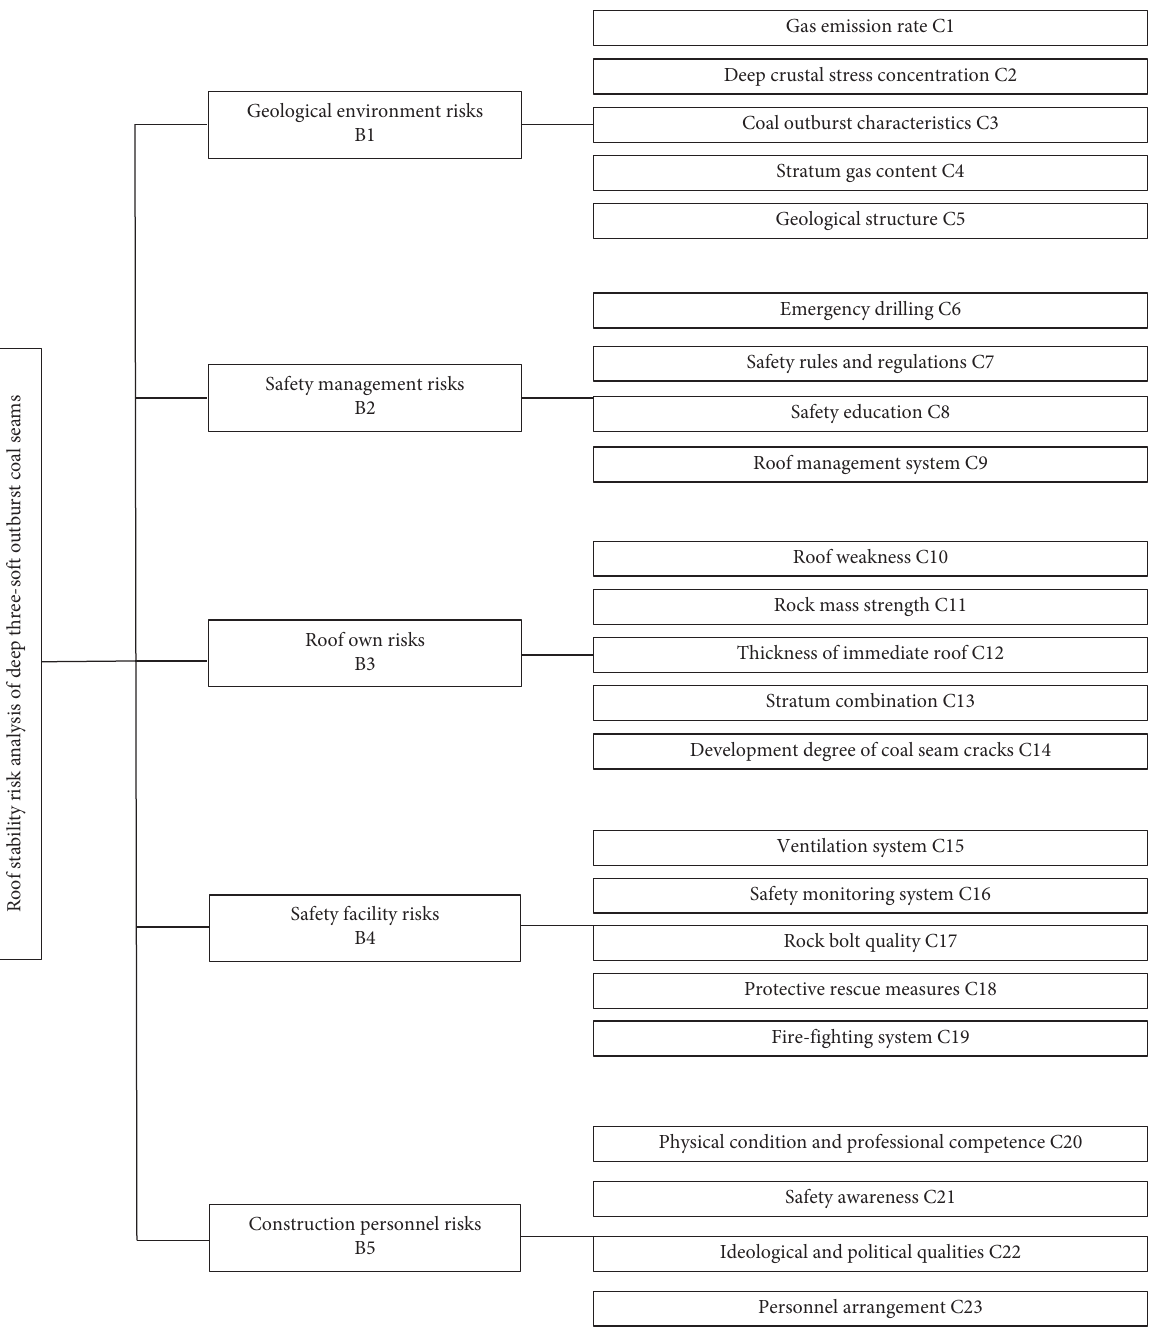
Figure 2: Stability risk assessment indicators of Lugou Mine’s three-soft coal seam outburst roof. Table 2: B - B judgment matrix. Target layer